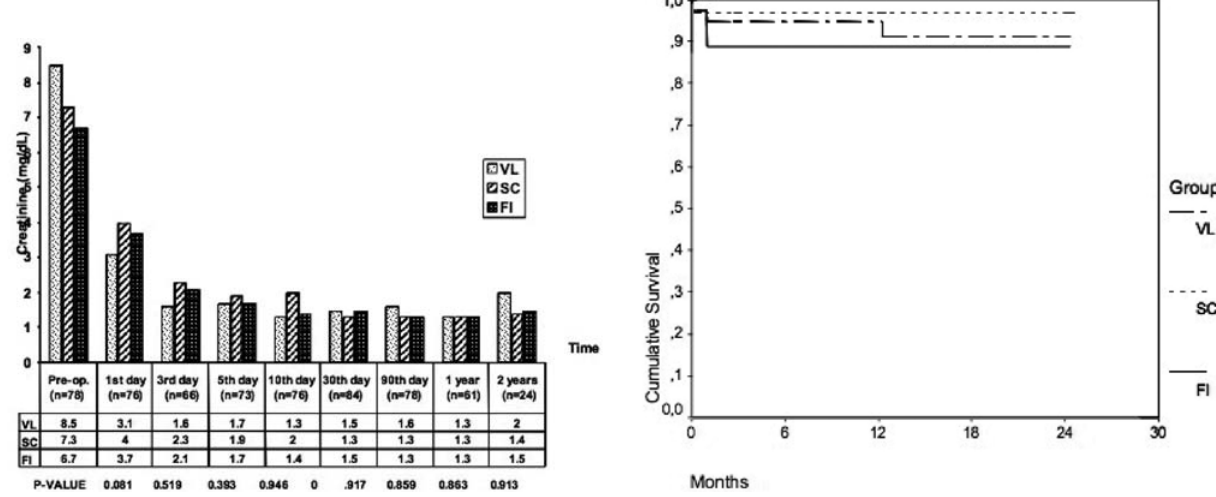
Figure 1 - Mean serum creatinine levels during hospitalization and follow-up Figure 2 - Recipient overall survival according to type of